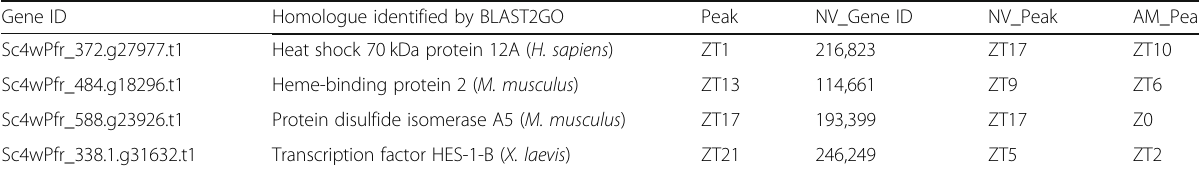
Table 4 Homologous pairs of diel cycle genes in three cnidarian species ( Hydra vulgaris , Nematostella vectensis and Acropora millepora ) Gene ID